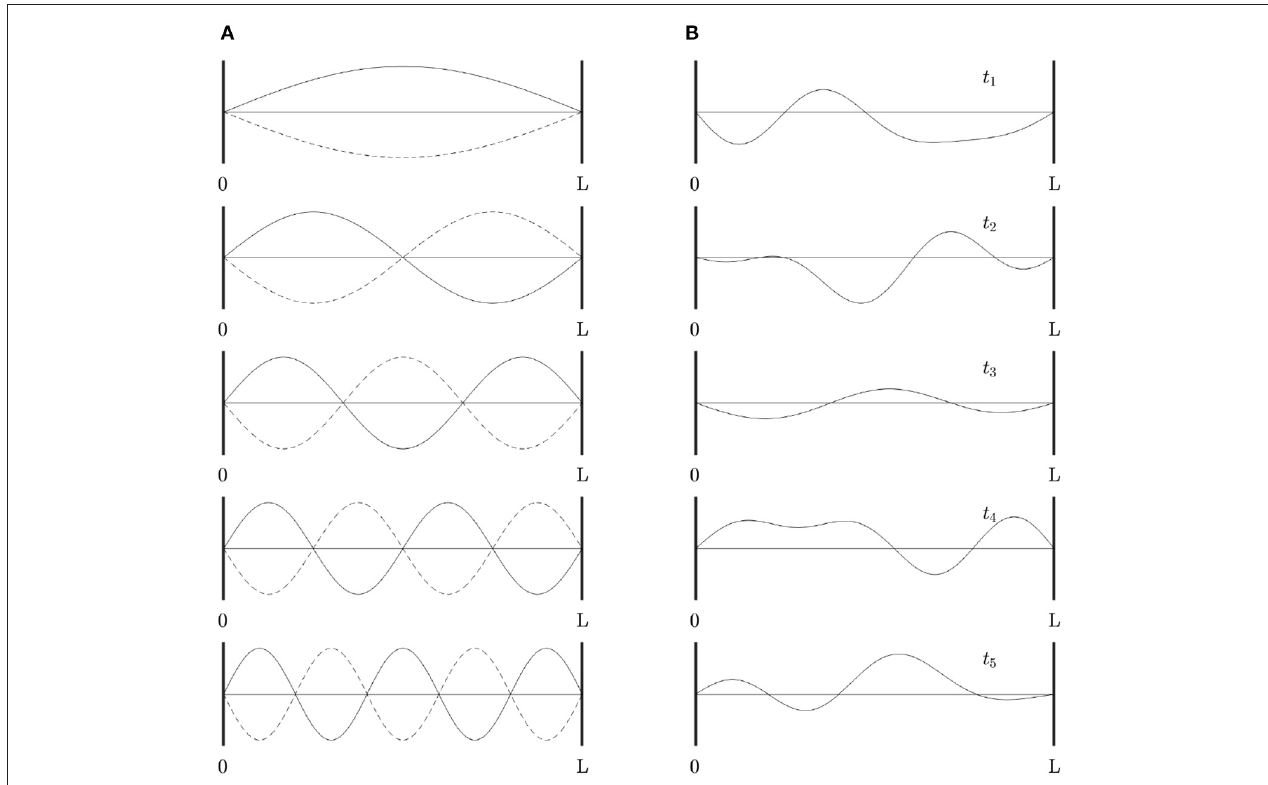
FIGURE 2 | Eigenmodes of a violin string clamped at both ends. (A) First five modes, showing waveform at times (solid and dotted) half an oscillation apart. (B) Examples of waveforms obtained by superposition of the modes in (A) at times t 1 ... t 5 , with frequencies proportional to the mode number as in a real violin string, equal amplitudes, and random initial